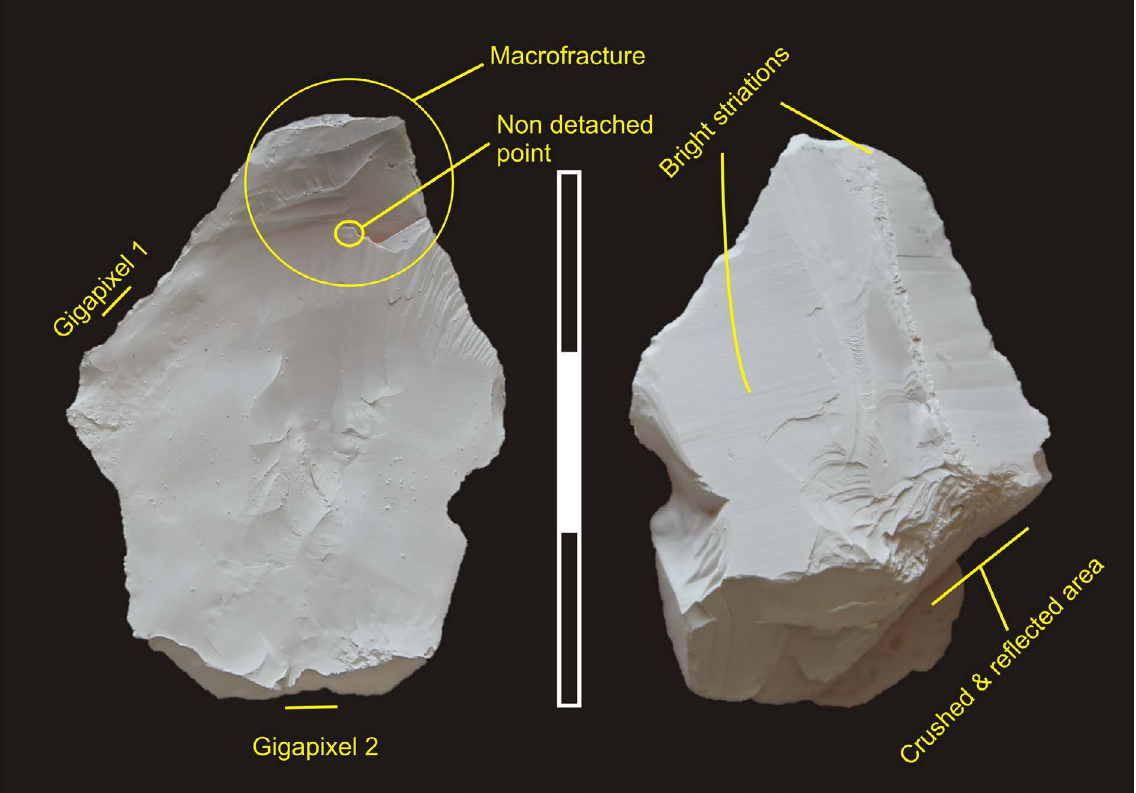
Figure 5. Both faces of the tool with the magnesium. Location of the main features described in the